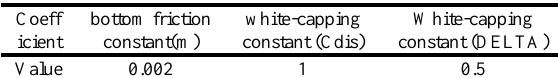
Figure 2. Case study and mesh elements with adding bathymetry data